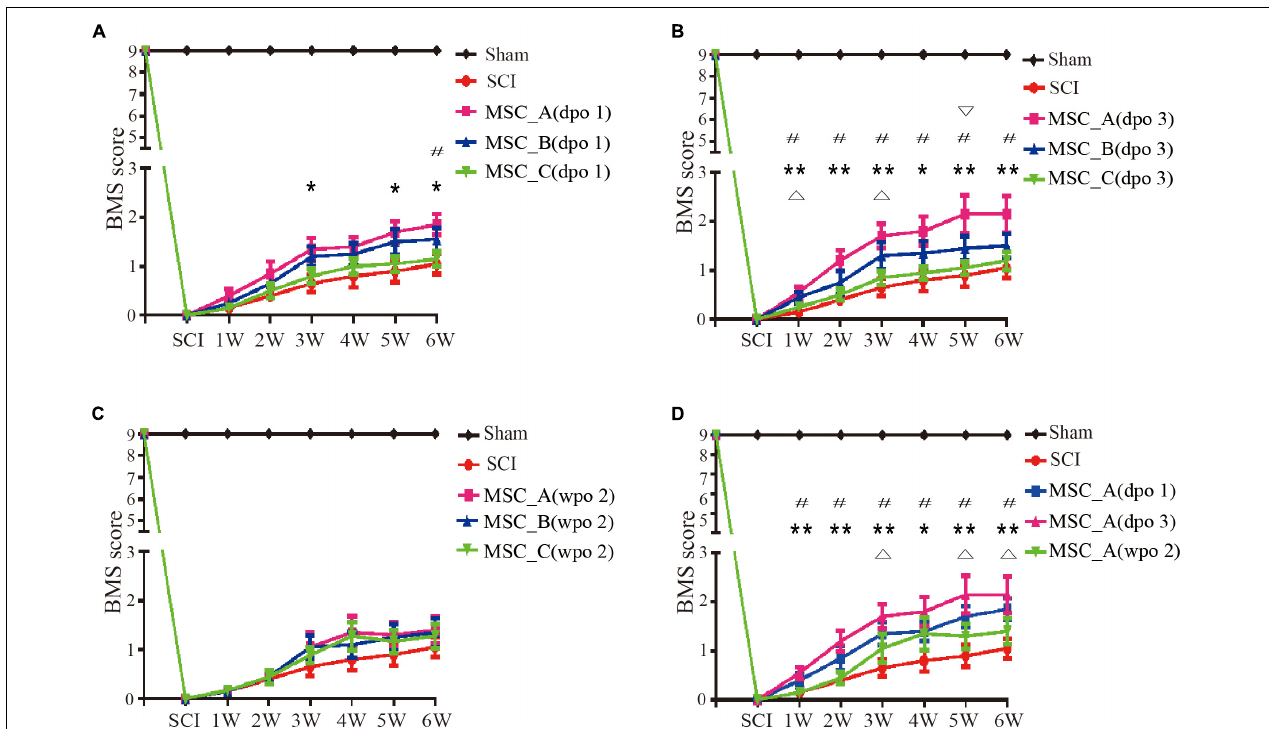
FIGURE 2 | Recovery of the motor function assessed by Basso Mouse Scale (BMS) scores over time. (A) The BMS scores were compared with the spinal cord injury (SCI) group when hUCMSC transplantation was performed at dpo 1. * p < 0.05, ** p < 0.01 MSC_A group compared with the SCI group; # p < 0.05 MSC_A group compared with the MSC_C group. (B) The BMS scores were compared with the SCI group when hUCMSC transplantation was performed at dpo 3. * p < 0.05 MSC_A group compared with the SCI group; # p < 0.05 MSC_B group compared with SCI group; # p < 0.05 MSC_A group compared with the MSC_C group; ∇ p < 0.05 MSC_A group compared with the MSC_B group. (C) The BMS scores were compared with the SCI group when hUCMSC transplantation was performed at wpo 2. (D) The BMS scores were compared with the SCI group when MSC_A transplantation was performed at different time points including dpo 1, dpo 3, and wpo 2. * p < 0.05, ** p < 0.01 MSC_A dpo 3 compared with the SCI group; (cid:49) p < 0.05 MSC_A dpo 1 compared with the SCI group; # p < 0.05 MSC_A dpo 3 compared with the MSC_A wpo